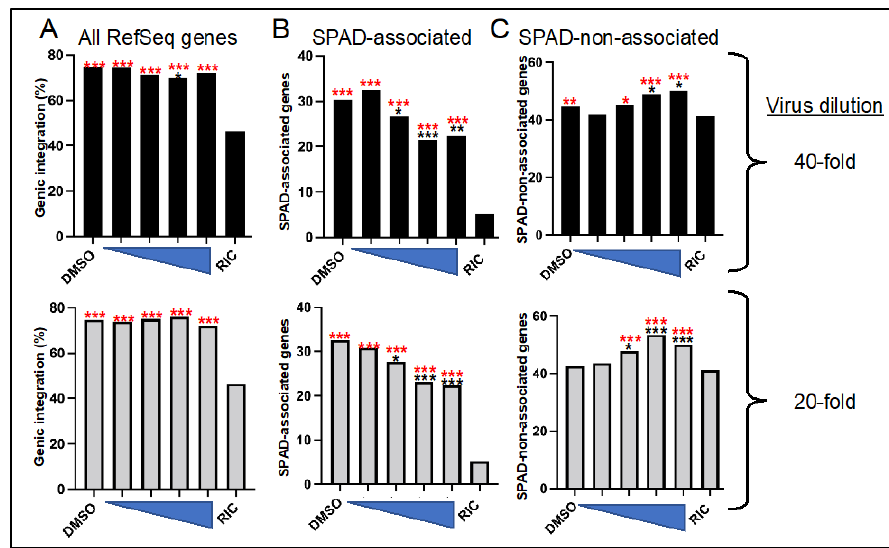
Figure 5. HIV-1 produced in the presence of CX014442 is defective for integration into SPAD-associated genes. ( A ) Percent integration into RefSeq genes as a function of CX014442 preexposure concentration (left to right, 31.25 nM to 250 nM, as indicated by triangle thickness). The upper panel is from virus diluted 40-fold prior to infection while the lower panel is from 1:20 diluted virus. ( B ) Same is in panel A except that percent integration into SPAD-associated genes was mapped. ( C ) Same as in panel A except that percent integration into SPAD-non-associated genes is shown. Asterisks show statistical differences versus matched RIC (red) or DMSO (black) controls. *, p < 0.05; **, p < 0.001; ***, p < 0.0001—see Table S4 for detailed statistical analyses.